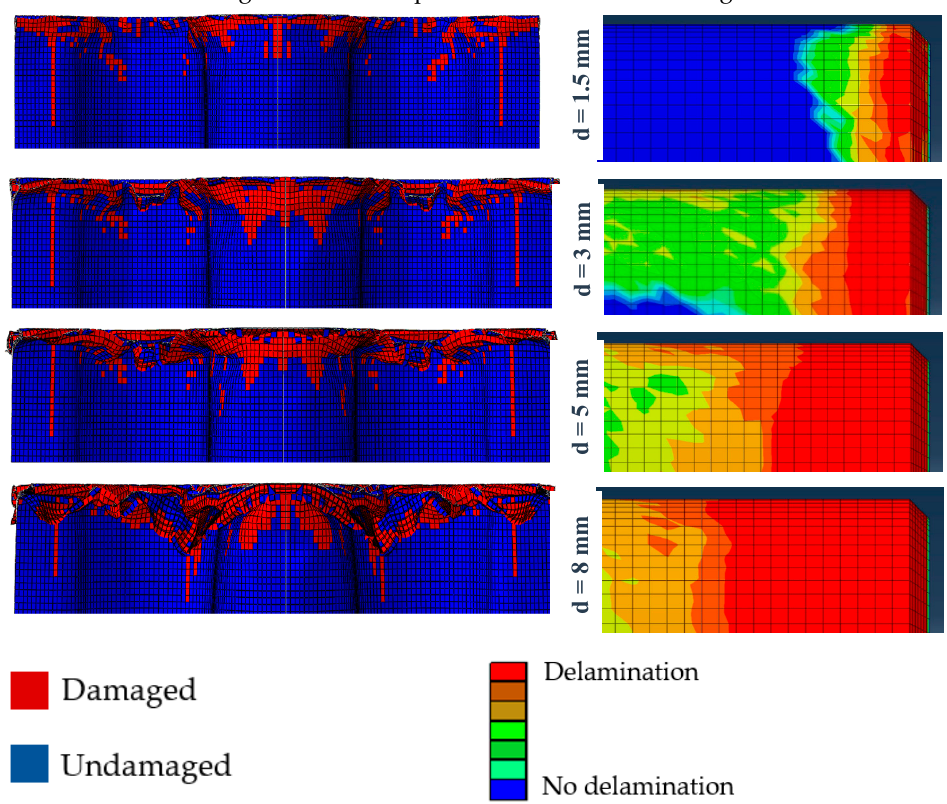
Figure 16. Matrix crack and delamination growth in the FE model with an artificial plug-initiator.